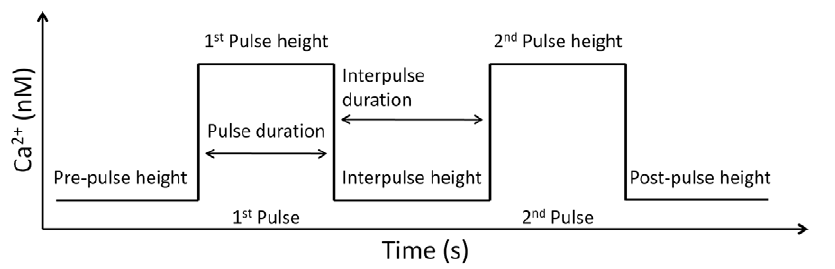
Figure 7. The Ca 2 + pulse waveform used in the experimental setup. The Ca 2 + pulse delivery system was capable of adjusting the pre-pulse height, pulse height, pulse duration, interpulse duration, interpulse height and post-pulse height. For details concerning specific operational characteristics of the apparatus, see [72].